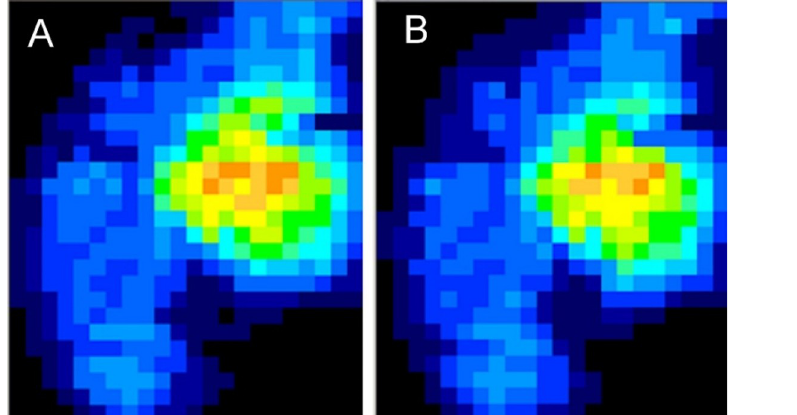
Fig 4. Force mapping of medial knee compartment